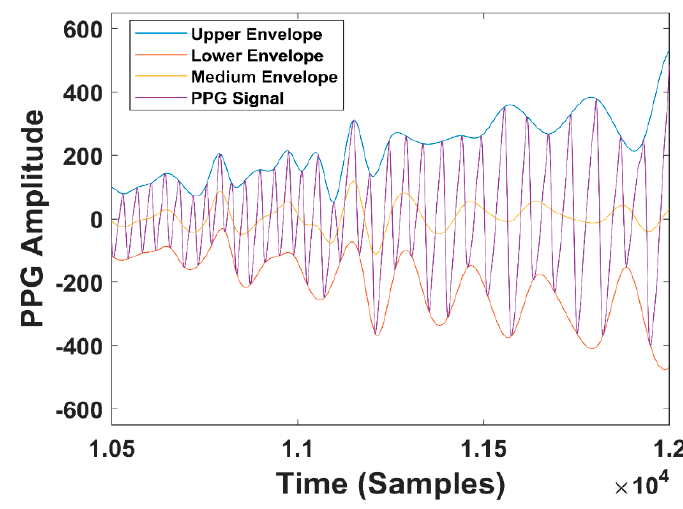
Figure 9. Upper, medium, and lower (not used) envelopes of the PPG signal.